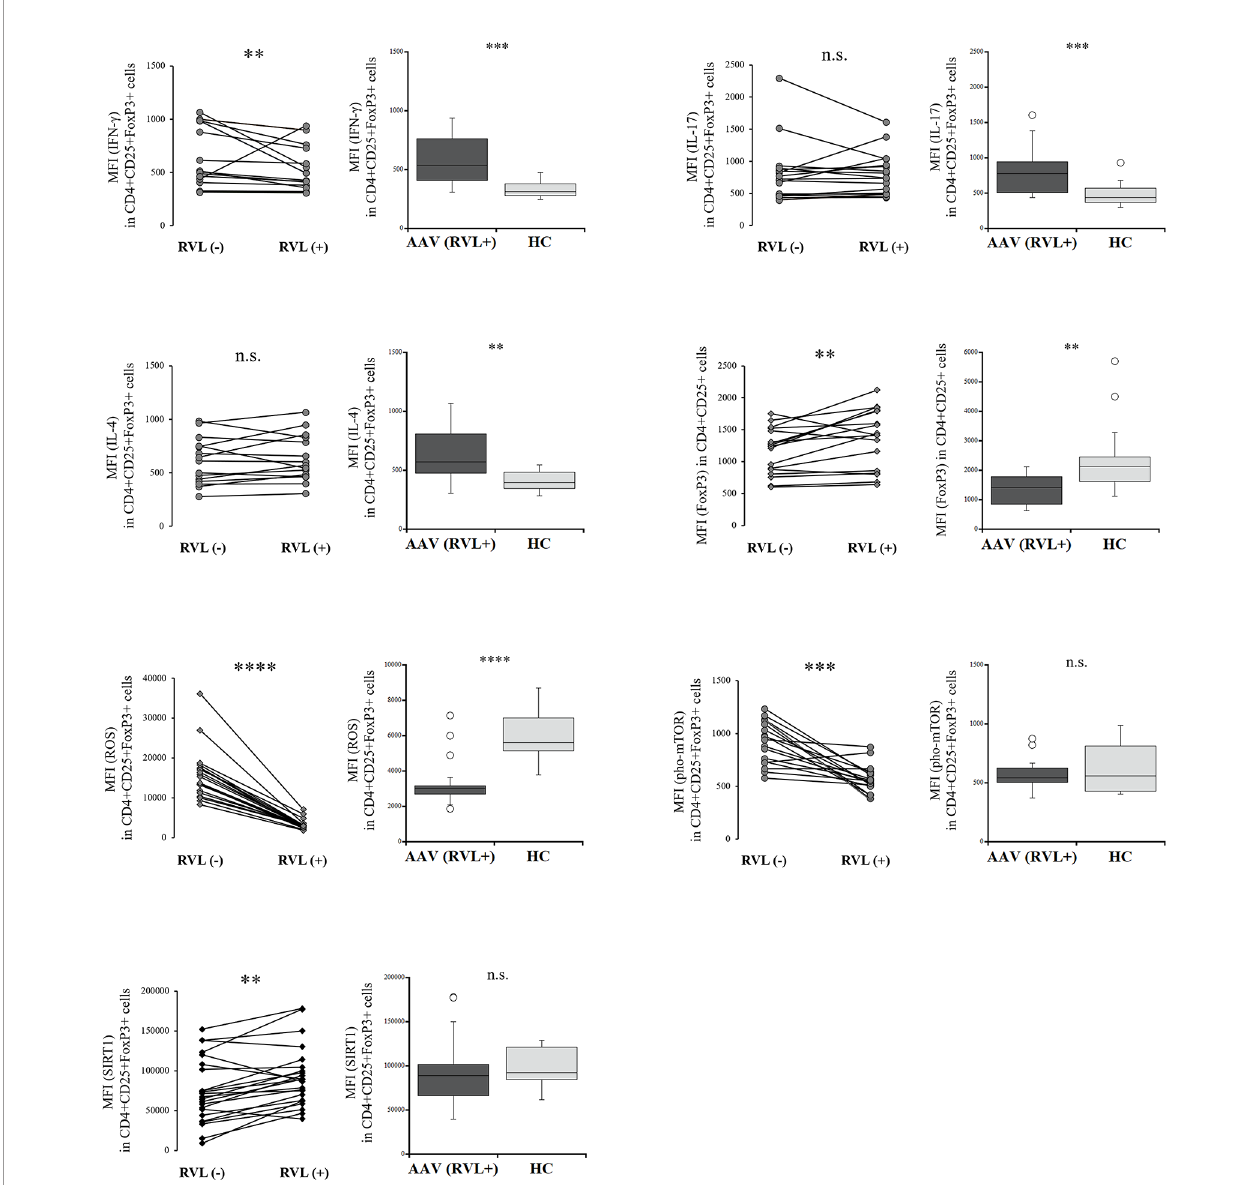
FIGURE 3 | Comparisons of regulatory T cells with and without resveratrol (RVL) treatment in the patients with AAV. Comparisons with and without RVL treatment (left) and those between after RVL treatment in the patients with AAV and healthy controls (HC) (right), with regards to median fl uorescence index (MFI) of interferon- g (IFN- g ), interleukin (IL)-17, or IL-4 in CD4+CD25+FoxP3+ cells (n = 18), MFI of FoxP3 in CD4+CD25+FoxP3+ cells (n = 18), MFI of ROS in CD4+CD25+FoxP3+ cells (n = 20), MFI of phosphorylated mammalian target of rapamycin (pho-mTOR) in CD4+CD25+FoxP3+ cells (n = 18), and MFI of sirtuin 1 (SIRT1) in CD4+CD25+FoxP3+ cells (n = 23). n.s., not signi fi cant; ** p < 0.005; *** p < 0.001; **** p <